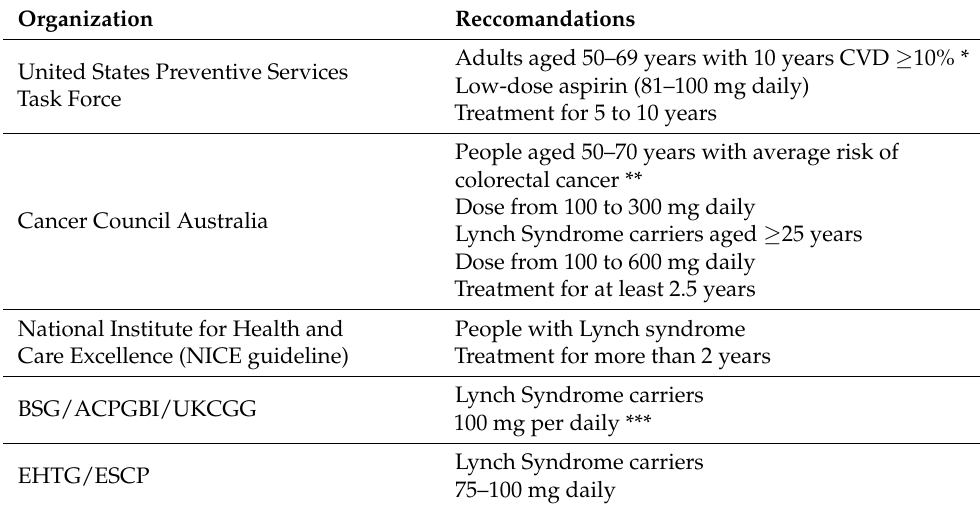
Table 1. A schematic representation of the main guideline recommendations for colorectal cancer preventive medicine with